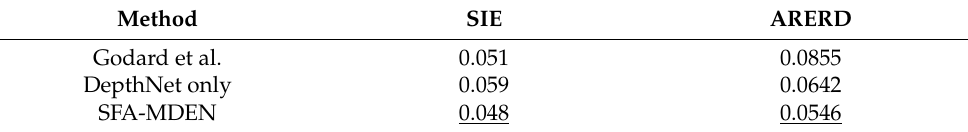
Table 3. Evaluation on the metrics of SIE and ARERD. We highlight the best results with an